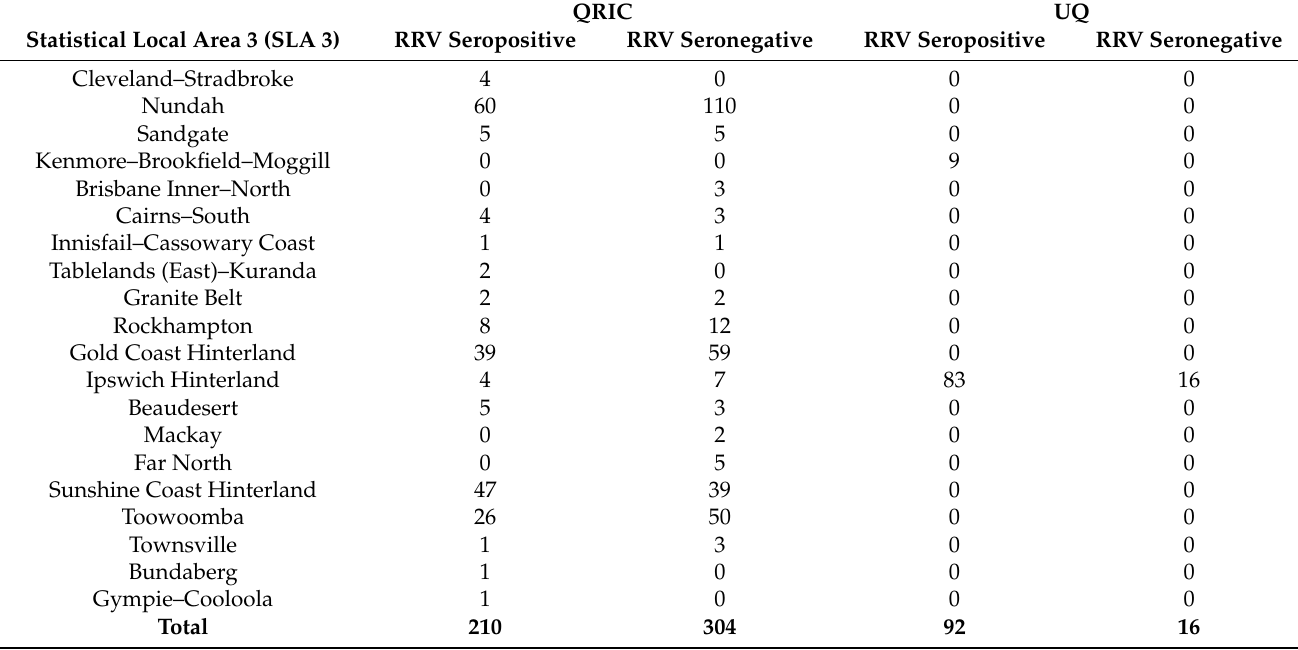
Table 4. Distribution of QRIC and UQ sample population across